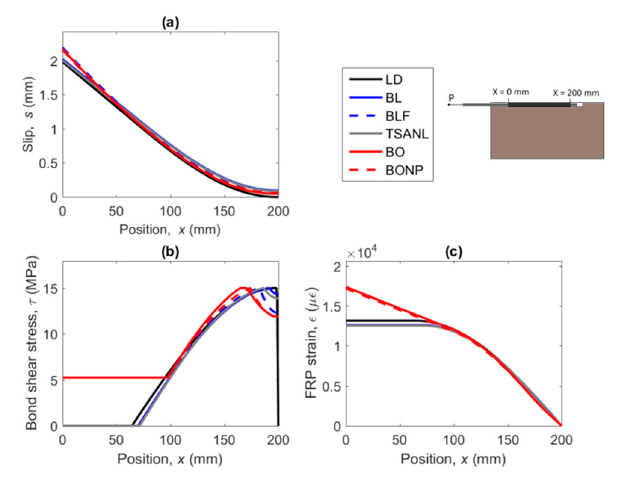
Figure 8. (a) FRP slip, (b) bond–shear stress, and (c) FRP strains along the bonded length for the different bond–slip